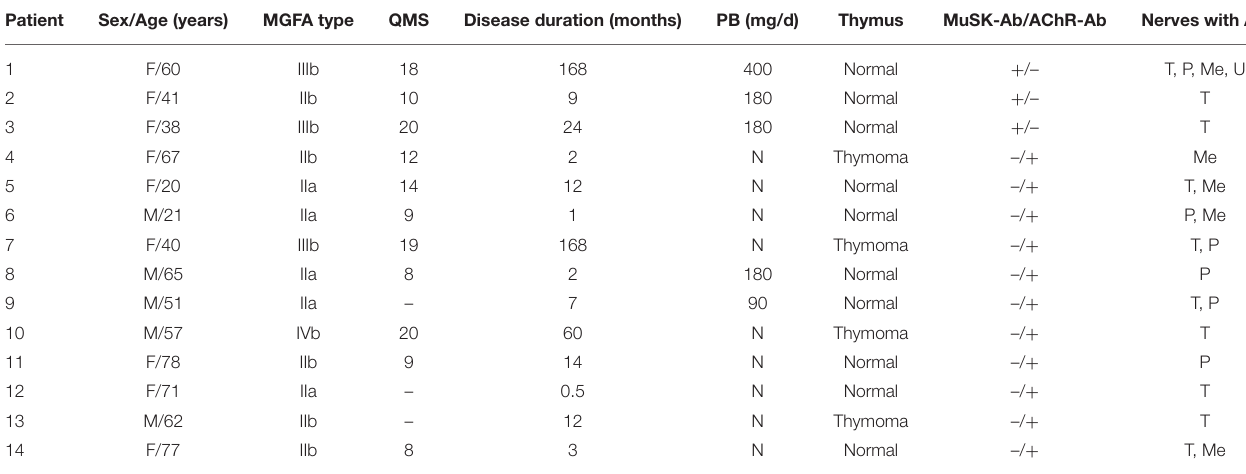
TABLE 1 | Clinical characteristics of patients with MG with afterdischarges.